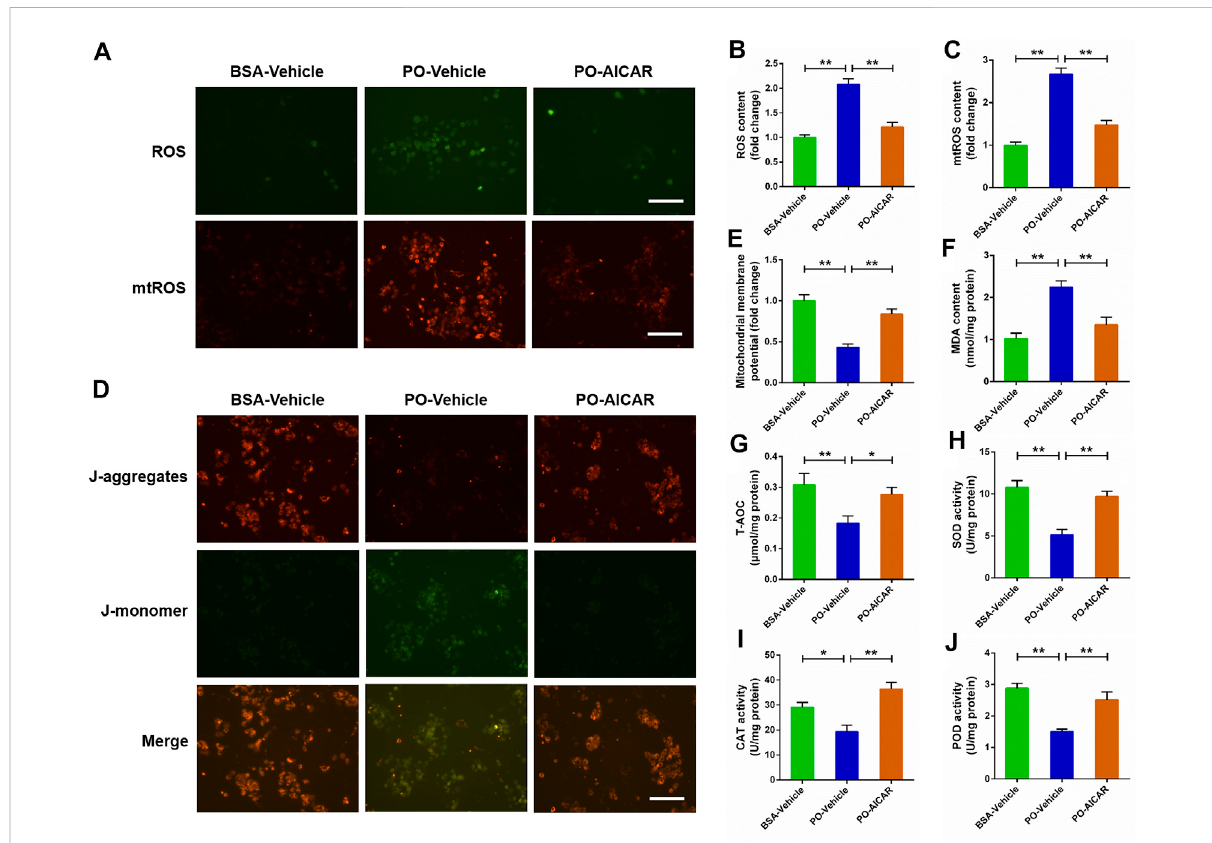
FIGURE 6 Activation of AMPK signal alleviates the oxidative stress challenged by PO in primary chicken hepatocytes. The primary chicken hepatocytes were pre-treated with/without 1 mM AMPK activator AICAR for 1 h, and then stimulated with/without 0.75 mmol PO for another 24 h. (A) Fluorescencephotographyofreactiveoxygenspecies(ROS)(scalebars,100 μ m)andmitochondrialROS(mtROS)(scalebars,100 μ m); (B) Statistical analysis of ROS level; (C) Statistical analysis of mtROS level; (D) Fluorescence photography of mitochondrial membrane potential (MMP) were detectedbyJC-1(scalebars,100 μ m); (E) Statisticalanalysis ofMMP; (F) Malondialdehyde (MDA)content; (G) totalantioxidant capacity(T-AOC); (H) Superoxide dismutase (SOD) activity; (I) Catalase (CAT) activity; (J) Peroxidase (POD) activity. Values represent the means ± SE. * p < 0.05 and ** p < 0.01, signi fi cantly different between the indicated treatment